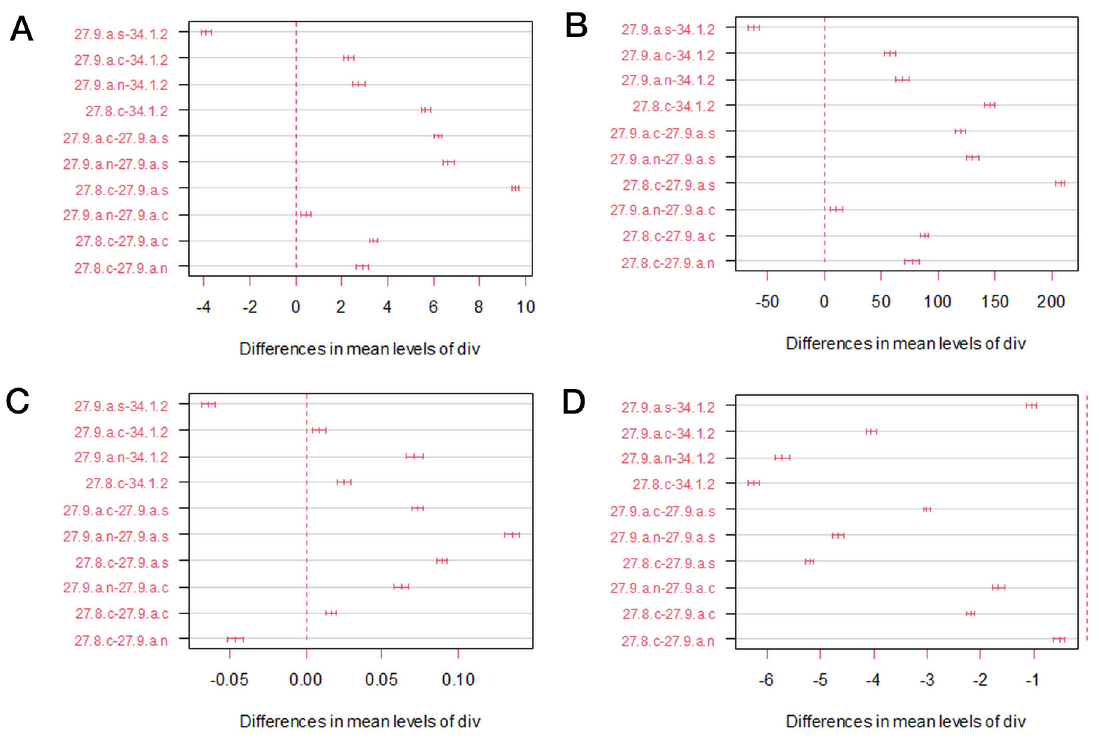
S3. – Plots of the estimated differences in mean levels of pairwise comparison between study areas. A) total length (cm); B) total weight (g); C) Fulton’s condition factor (K); D) sea surface temperature (°C). Geographical study areas from south to north are 34.1.2, Canary